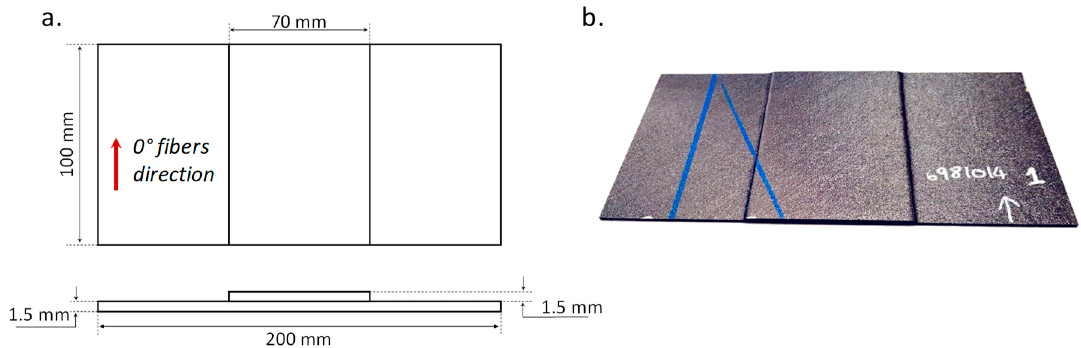
Figure 3. Fiber-reinforced composite coupon: ( a ) geometrical description; ( b ) picture of the tested